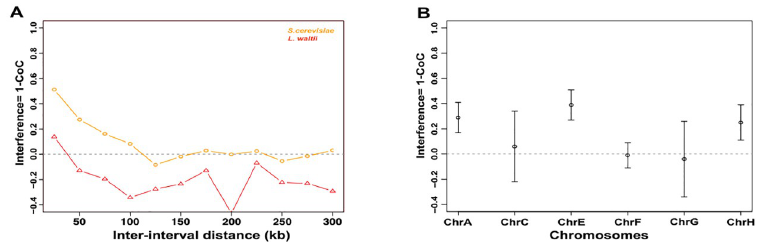
Fig 4. Crossover interference in L . waltii . A . Crossover interference (1-CoC) calculated for a bin size of 25 kb and inter-interval distance of 25 kb (i.e., for adjacent intervals) in L . waltii (triangle) and S . cerevisiae (circle). B . Chromosome-wide interference (1-CoC) in 192 L . waltii tetrads calculated for a bin size of 1/ (5 � (mean inter crossover distance)) for adjacent bins using MAD patterns